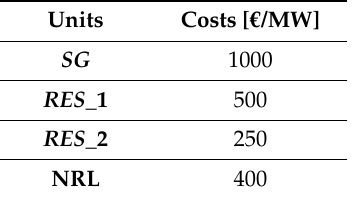
Table 2. Shedding costs of the network’s users.